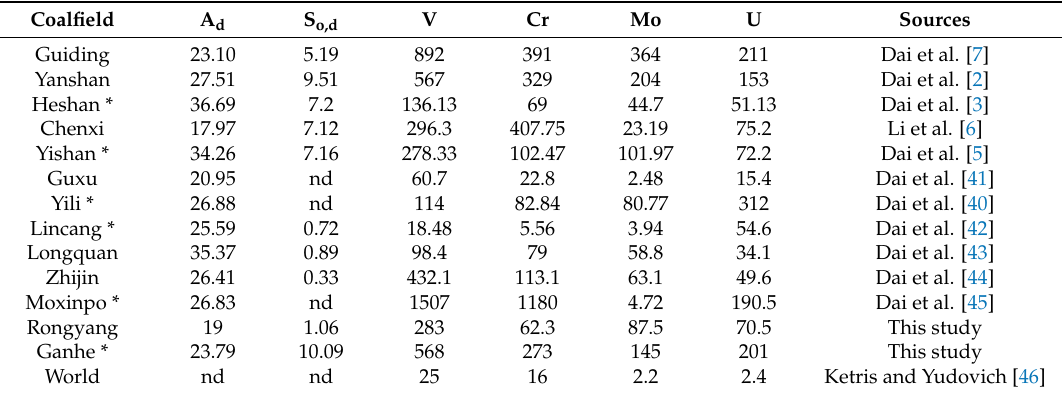
Table 1. Ash yield (%), S o,d (%), and concentrations of V, Cr, Mo, and U ( µ g/g) in high-U coals from China (on a whole coal